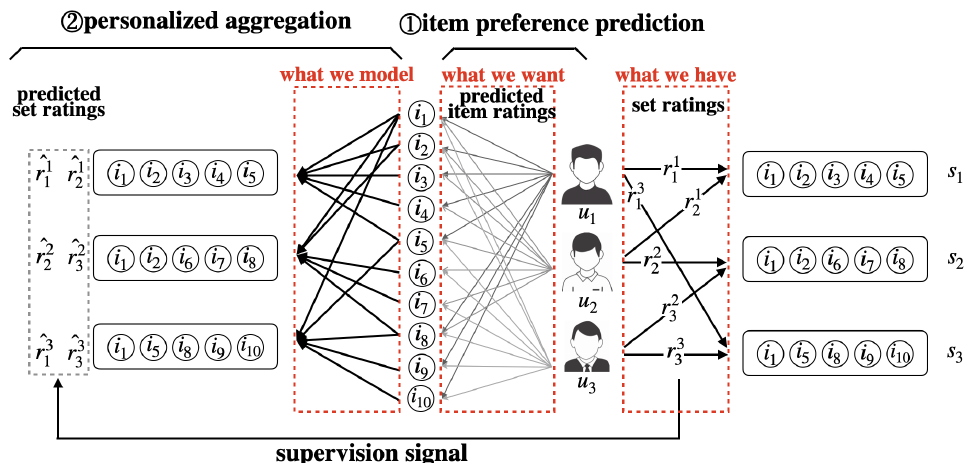
Figure 1. The illustration of set-based preference learning (SPL) problem settings. Users U = { u 1 , u 2 , u 3 } rate sets S = { s 1 , s 2 , s 3 } , which contain items randomly picked from I = { i 1 , i 2 , . . . , i 10 } . The set ratings user u gives, set s , are denoted as r s u . ˆ r s u is the predicted preference scores for user u ’s ratings of set s . The prediction process is optimized by minimizing the loss between r s u and ˆ r s u . ˆ r s u is aggregated from predicted item ratings in a personalized way. As the training process proceeds, the set-rating prediction becomes more accurate. As a by-product, we get more reasonable item-rating predictions. At this point, the goal of inferring user preference over individual items based on set-level feedback is